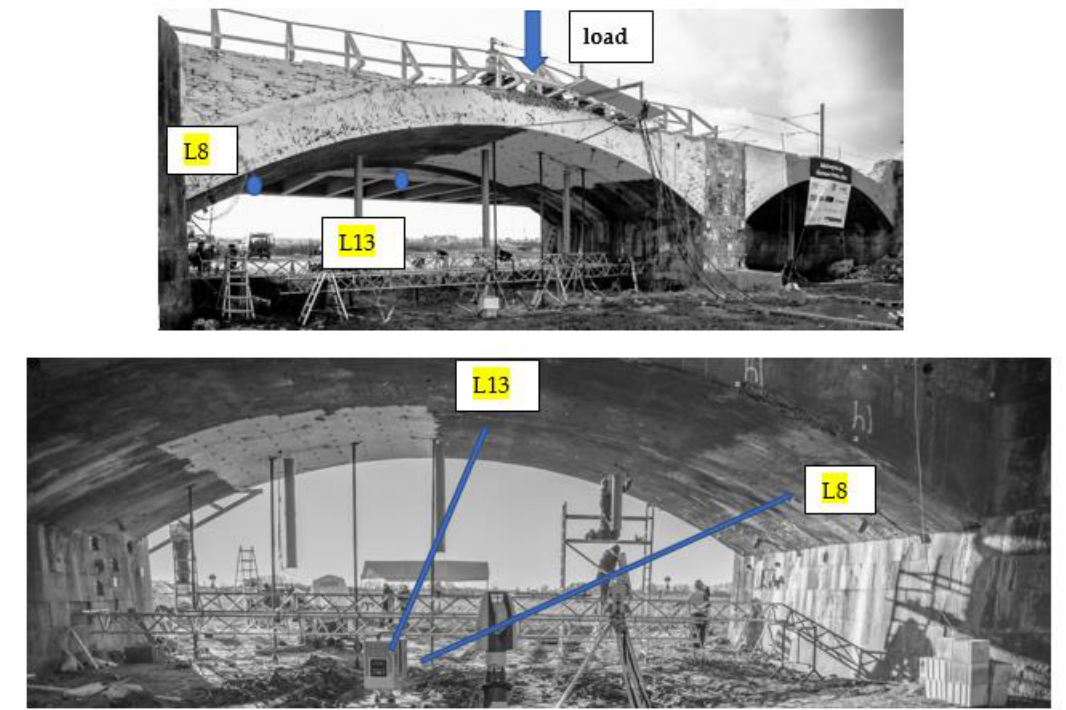
Figure 2. Bottom and top: Representation of the bridge under load with the localization of the two patches L13 and L8 under consideration. The load was positioned approximately in the middle of the bridge under which the TLS was positioned (images adapted from Reference [5]).